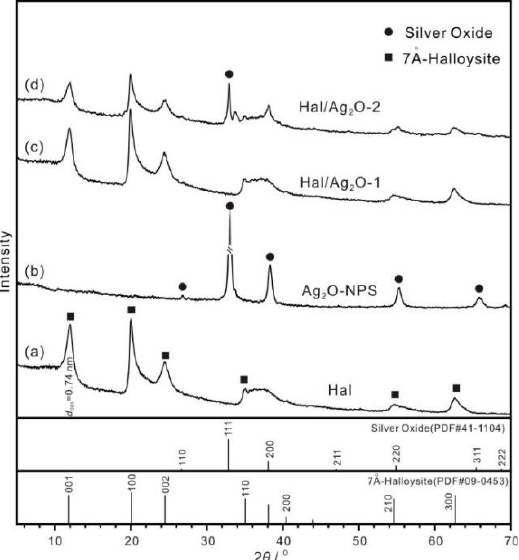
Figure 1. XRD patterns of ( a ) Hal, ( b ) Ag 2 O-NPS, ( c ) Hal/Ag 2 O-1, and ( d ) Hal/Ag 2 O-2.